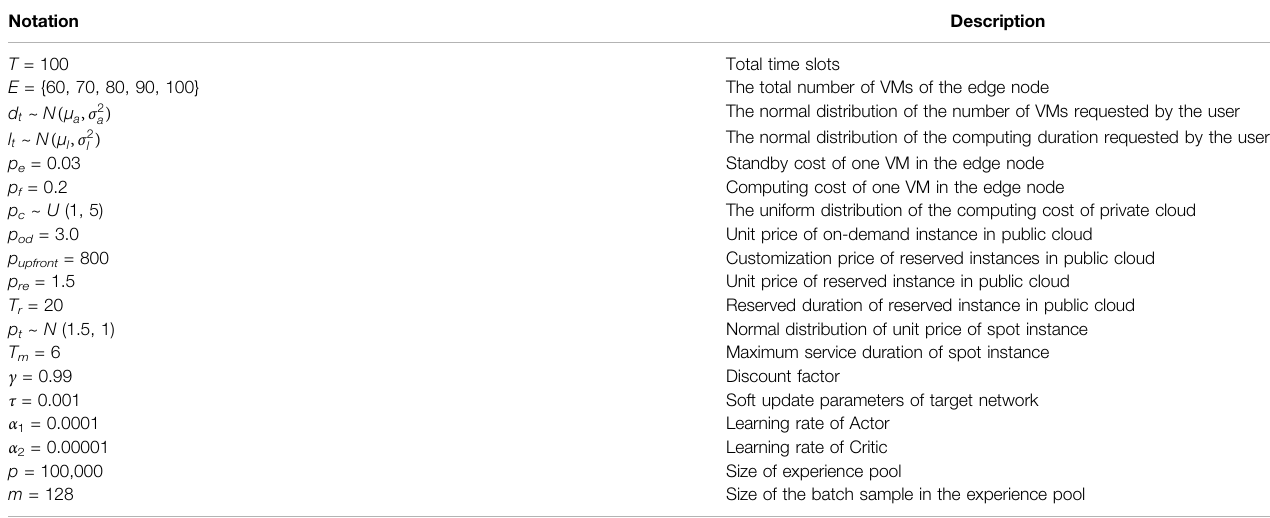
TABLE 2 | Parameter